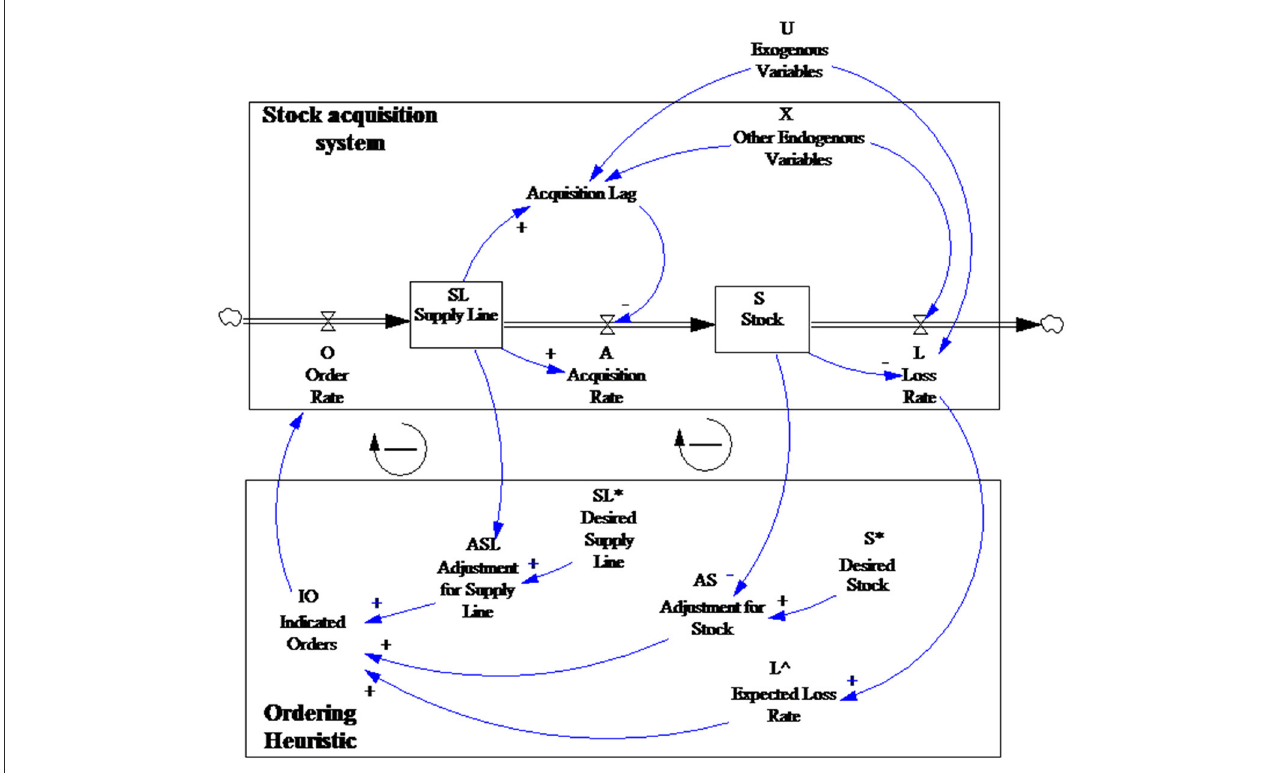
FIGURE3 The generic stock-management system by Sterman.